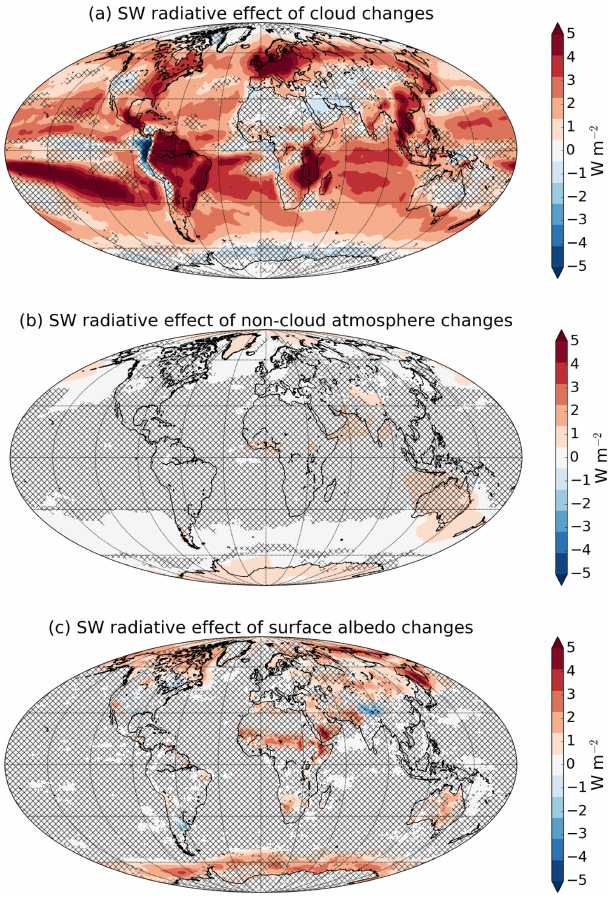
Figure 7. Multi-model mean change in net downward SW radiation at the TOA in G1 – piControl due to changes in cloud properties (a) , non-cloud atmospheric absorption and scattering (b) , and surface albedo (c) , calculated using APRP method (Taylor et al., 2007). Hatching indicates areas where fewer than seven of nine models agree on the sign of the change. CSIRO-Mk3L-1-2 and GISS-E2-R models are excluded because not all fields necessary for APRP were correctly archived.